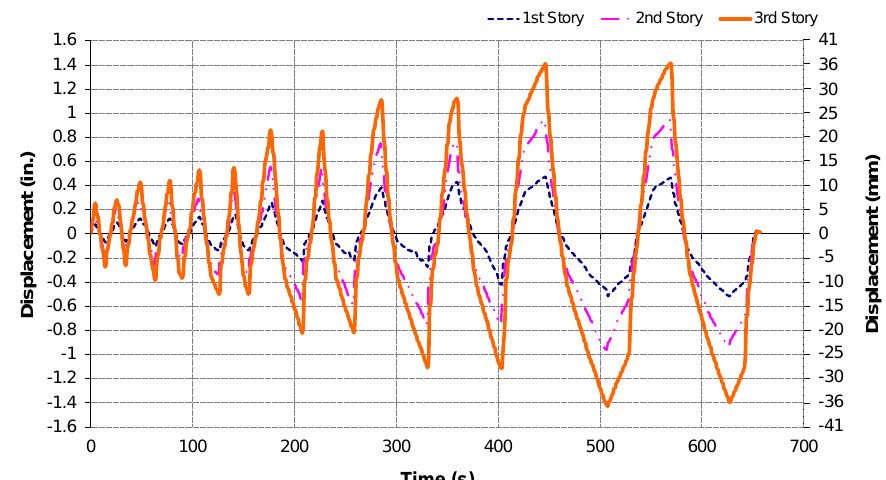
Figure 17. Full brace cyclic test FBCT4 displacement